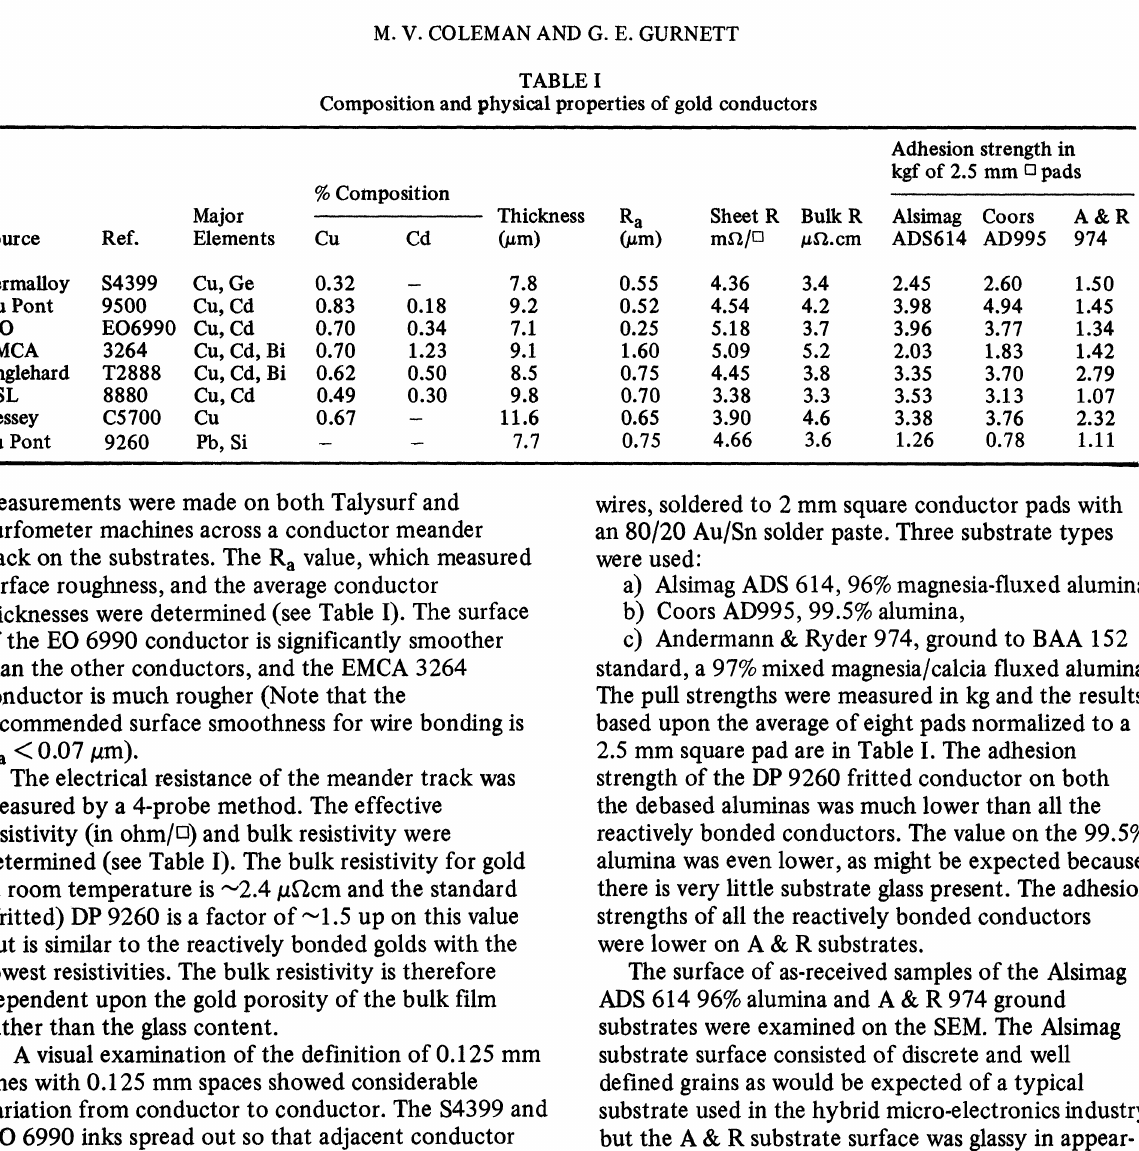
TABLE Composition and physical properties of gold